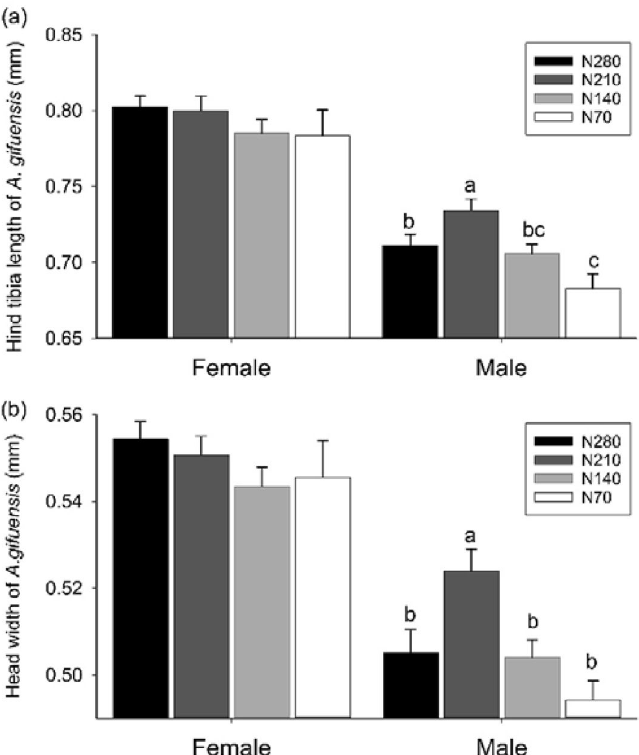
Figure 3. Body size of A. gifuensis ( a : hind tibia length; b : head width) (means + SE) in nitrogen fertilizer plots at the wheat flowering phase in 2017.